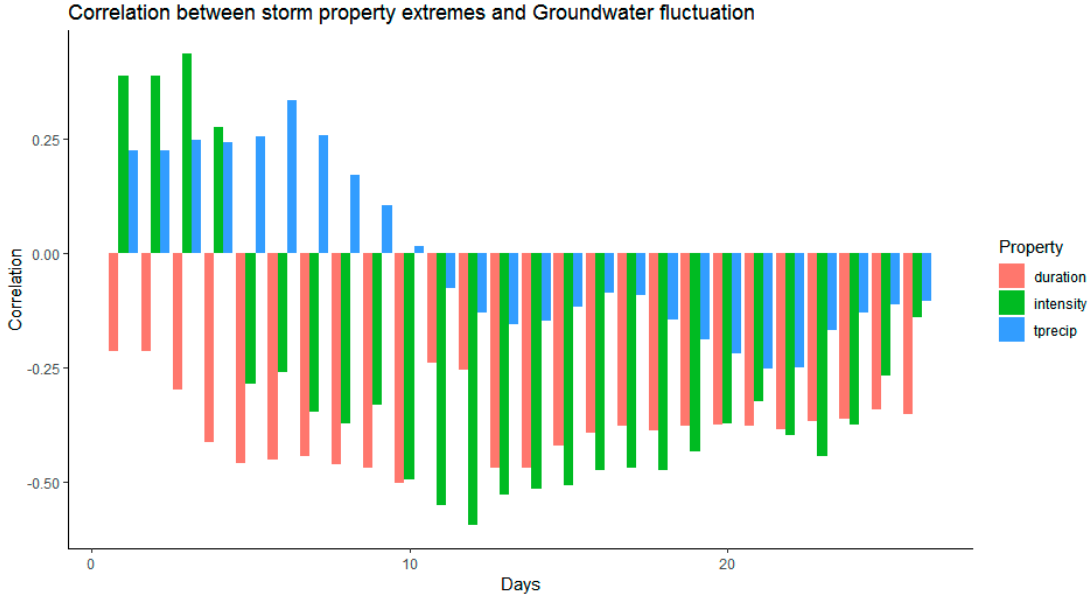
Figure 4. Correlation between the storm property extremes and depth to groundwater surface at different number of days lags, showing the slow evolving process. In the legend, “tprecip” represents “total precipitation”.